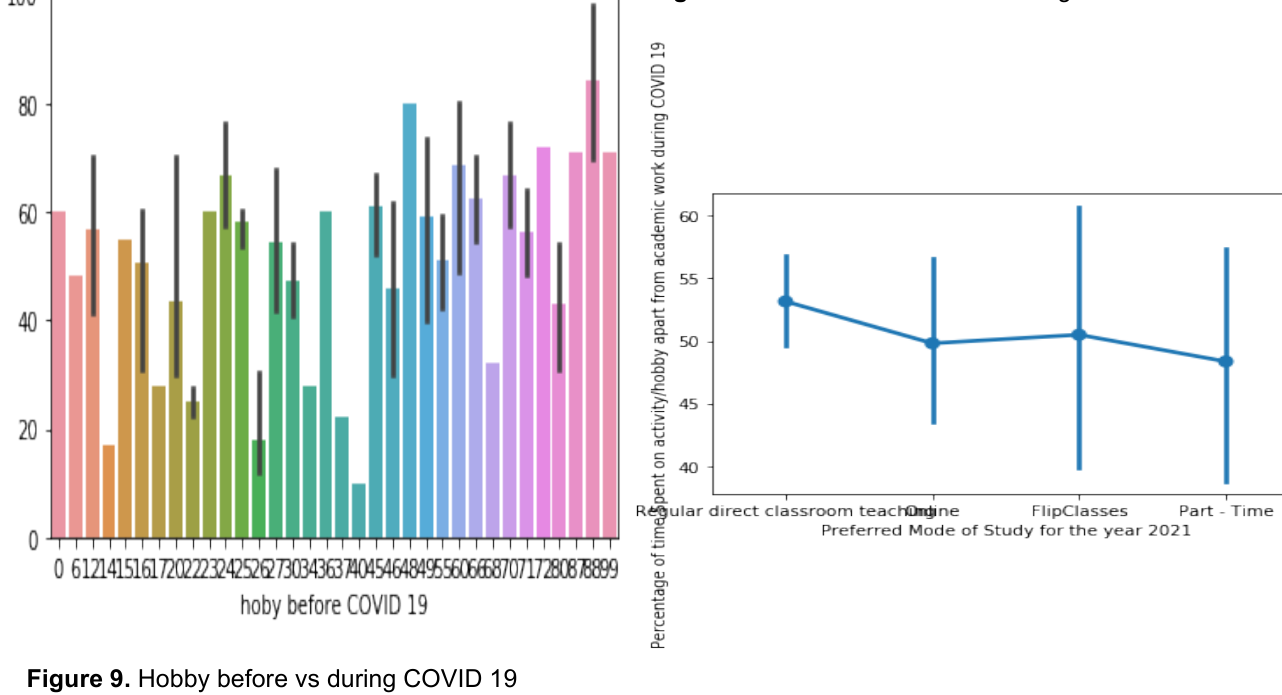
Figure 10. Academic before vs during COVID 19'